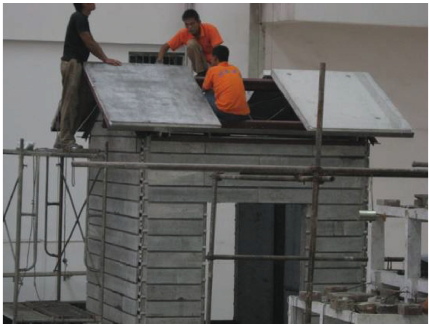
Figure 8: Installing roof slab. Aluminium plate with 1.5mm thickness is pasted on the surface of roof slab, and slab joints as well as lap joint are filled with polyurethane foamable